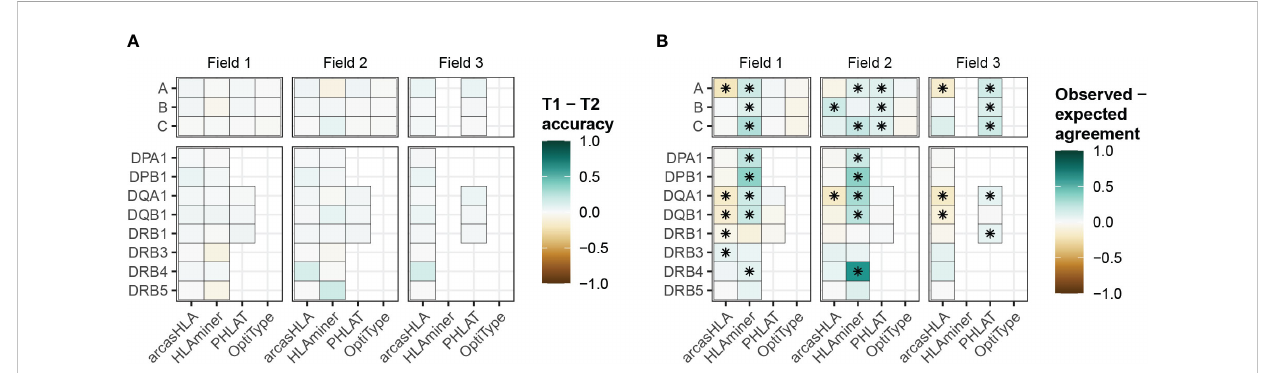
FIGURE 4 Reproducibility of predicted HLA genotypes (A) Difference in mean accuracy between genotype predictions at time point 1 (T1) and time point 2 (T2). (B) Mean difference between the expected agreement of T1 and T2 genotype predictions and their observed agreement. (*) FDR-adjusted p-value ≤ 0.05 by Wilcoxon rank sum